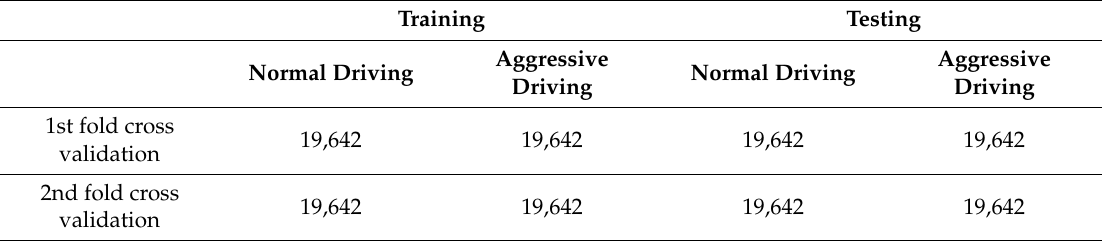
Table 3. Description of training and testing images from DDBC-DB1.